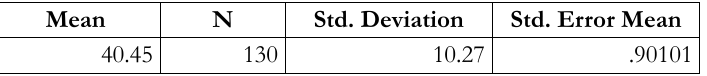
Table 11. Results of Average Pre-test Mathematical